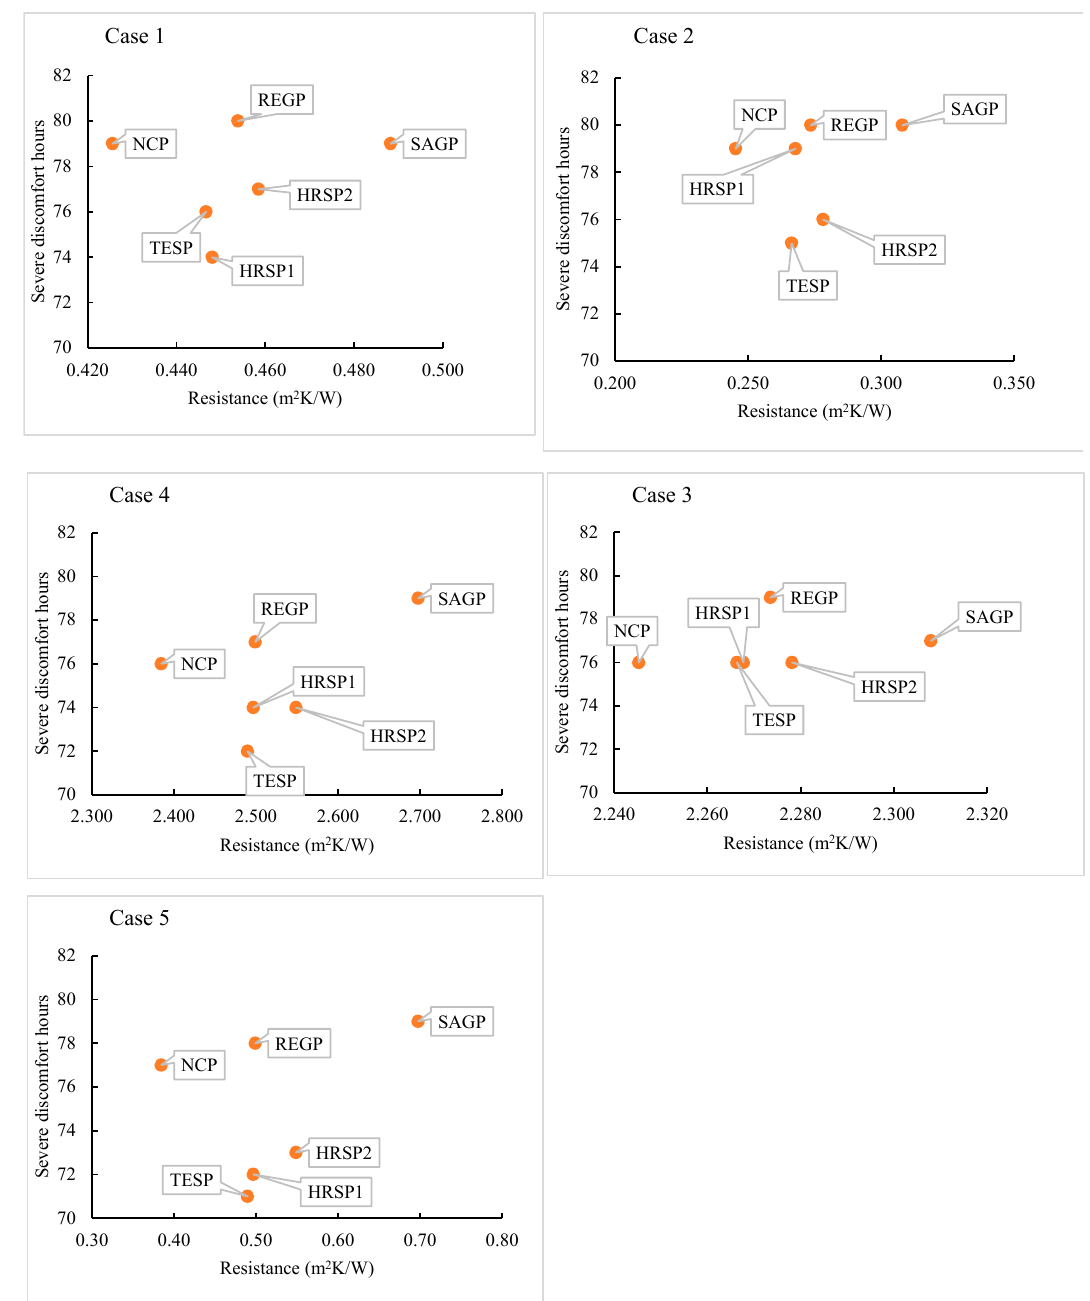
Figure 8. The effect of envelope resistance on the number of severe discomfort hours in the living zone.